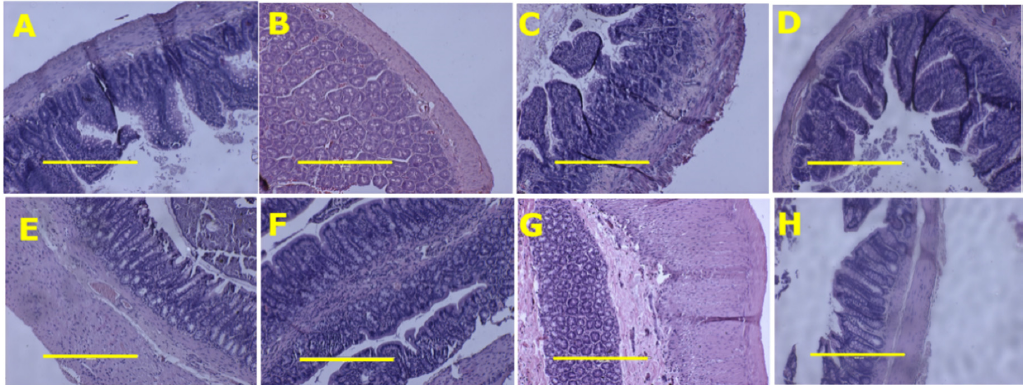
Figure 2. Ileum (top row) and colon (bottom row) structure using haematoxylin and eosin stain in corn starch diet-fed rats ( A,E ), corn starch diet-fed rats supplemented with Saskatoon berry powder ( B,F ), high-carbohydrate, high-fat diet-fed rats ( C,G ) and high-carbohydrate, high-fat diet-fed rats supplemented with Saskatoon berry powder ( D,H ). The yellow scale bar is 100 µm (10×).